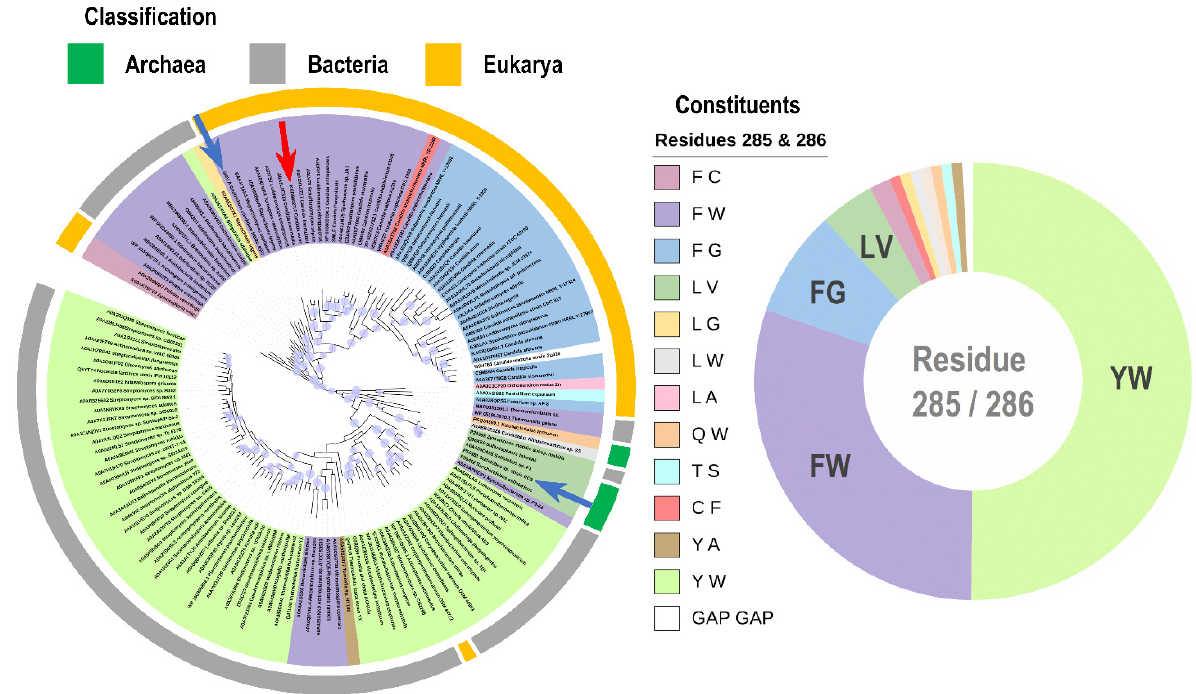
Figure 7. Phylogenetic tree of analogous proteins of alcohol dehydrogenases, with the maximum likelihood (ML) of 1000 bootstraps. The red indicator is Cp RCR and the blue indicators are ADH from Geotrichum candidum and Sulfolobus tokodaii (Figure S7). The proportion of the different combinations of amino acid residues at 285 and 286 sites was shown in the pie chart at the bottom-right corner.